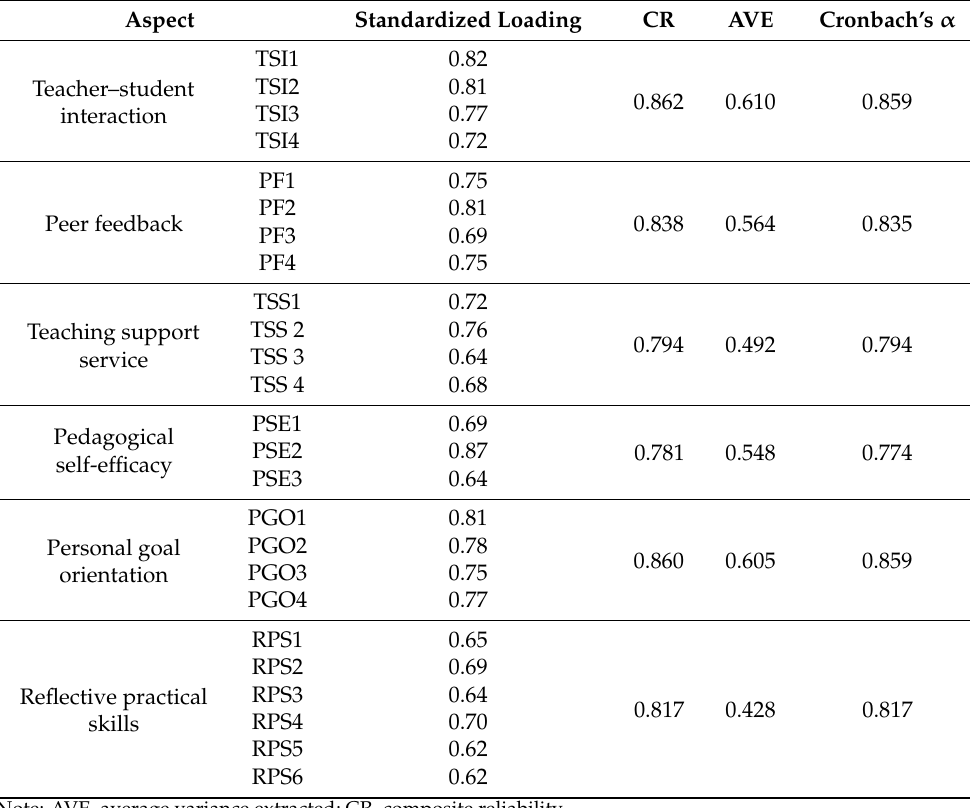
Table 2. Construct convergent validity.